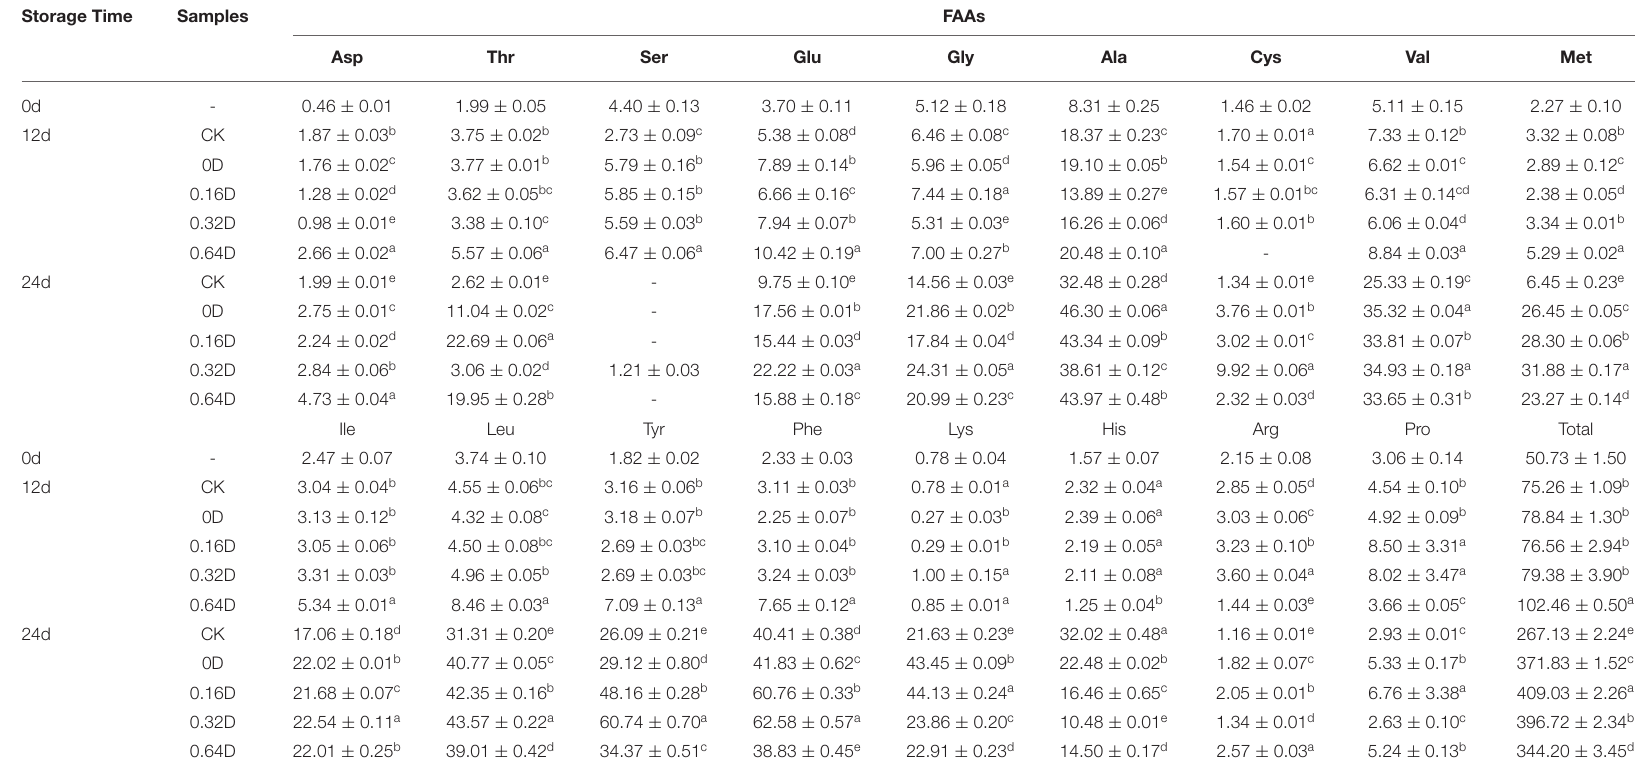
“-” is not detected. Different lowercase letters in different groups from the same day indicate significant differences (p <